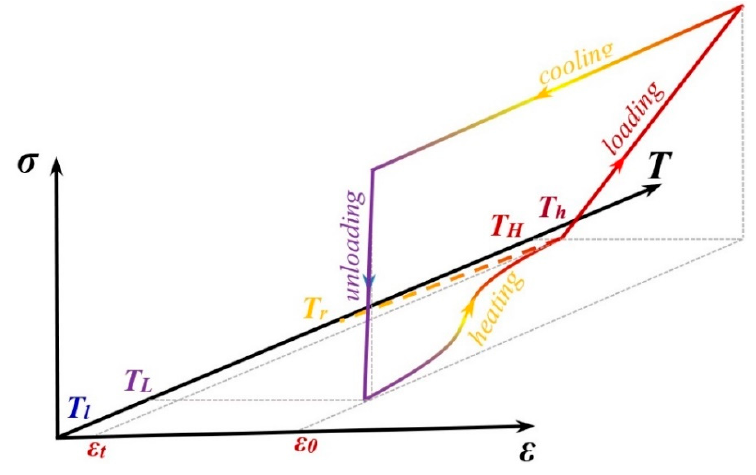
Figure 2. Shape memory polymer (SMP) thermo-mechanical cycle.